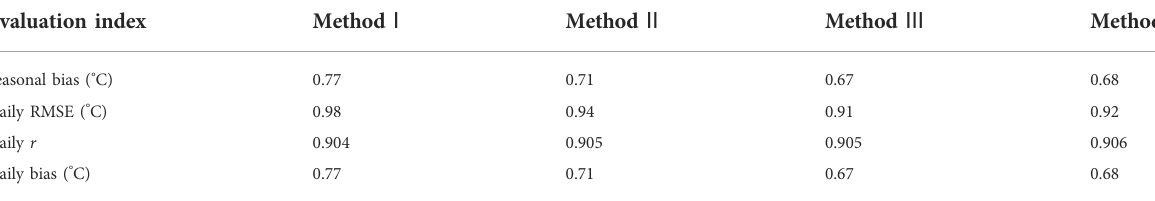
TABLE 9 Comparison of four correction methods based on Γ ERA